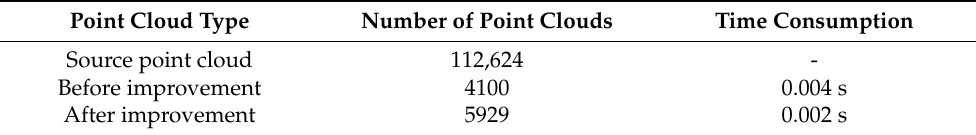
Figure 2. Comparison of point cloud downsampling results. ( a ) Source point cloud; ( b ) downsam- pling results before improvement; ( c ) downsampling results after improvement. Table 1. Comparison of the number of point clouds and time consumption after downsampling.